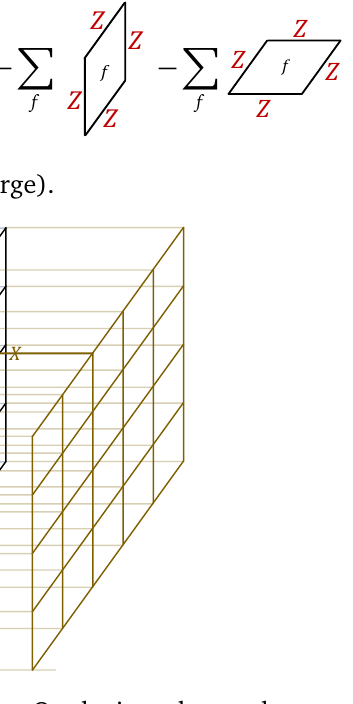
Figure 20: We prepare layers of 2d toric codes first. On the inter-layer edges, we put = + 1 states. These ancilla qubits will become the background ancilla qubits in X e gauge field when we condense bosons (gauge the 1-form